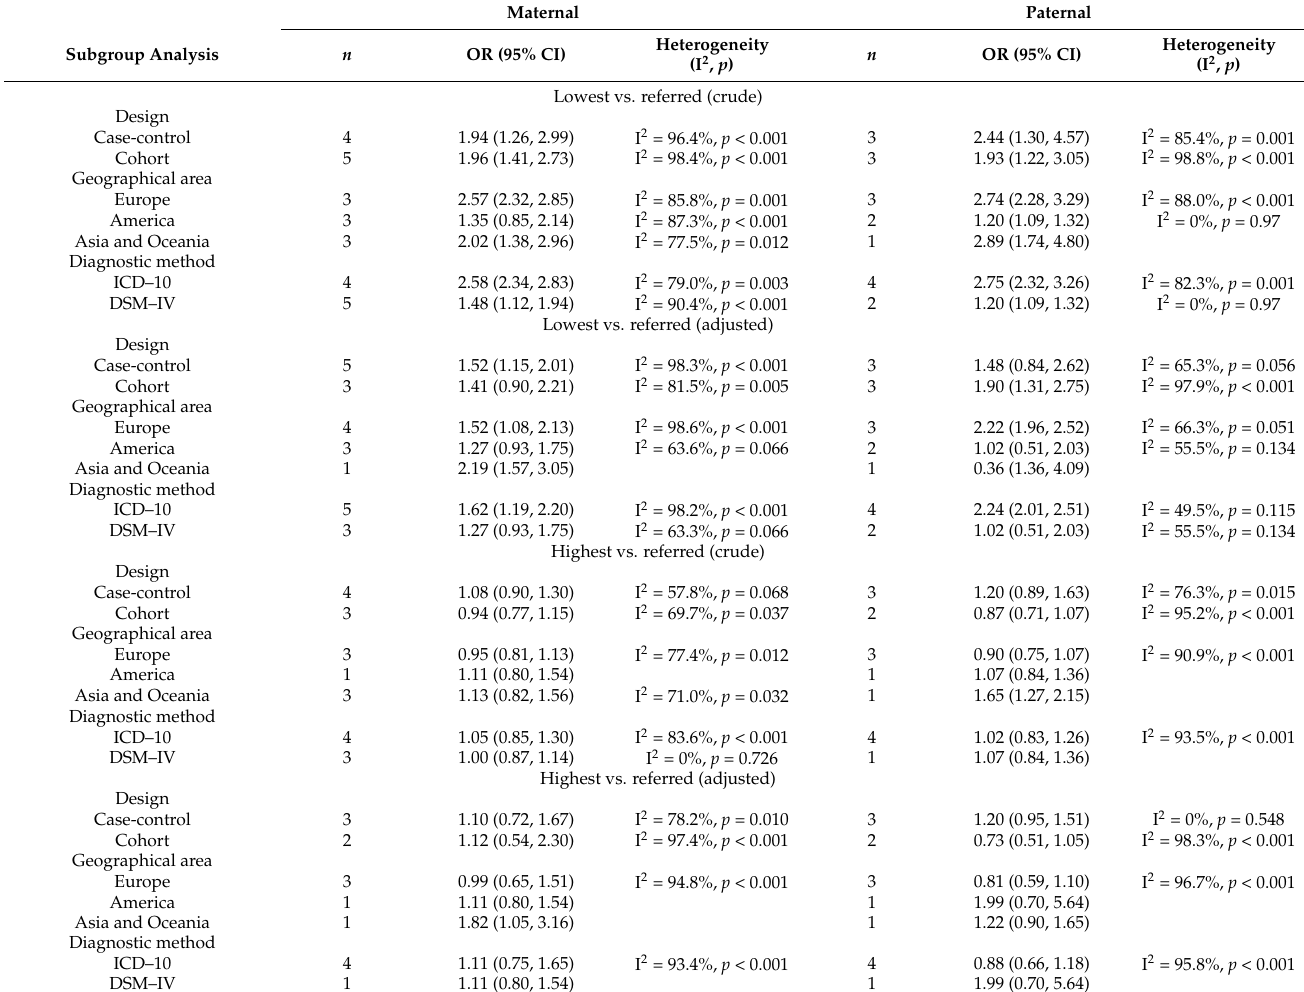
Table 2. Subgroup analyses for studies included in the